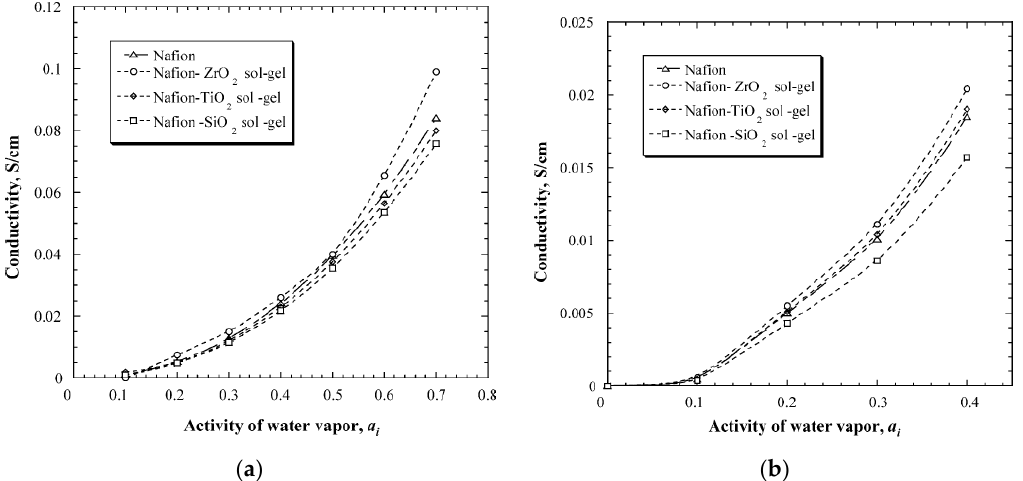
Figure 6. The conductivity of the measured membranes at different water activities at 90 °C ( a ) and 120 °C ( b ) . Reprinted with permission from Ref. [47]. Copyright 2005 Elsevier.